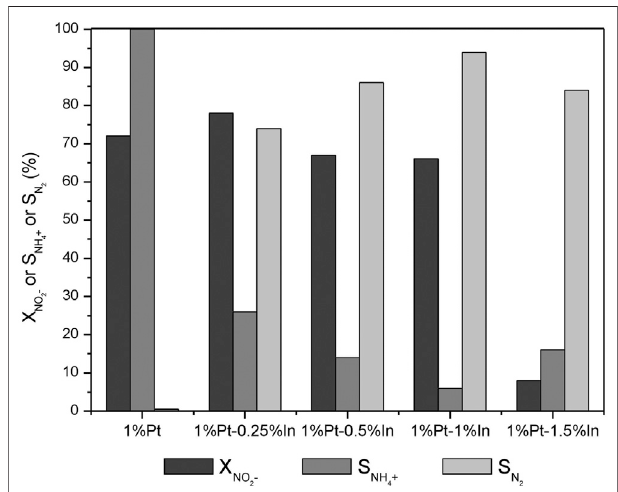
FIGURE 5 | Dark grey NO 2 − conversion, grey NH 4+ and light grey N 2 selectivities after 300 min of reaction on the activated carbon-supported 1% Pt-x%In/AC catalysts calcined and reduced at 400 °